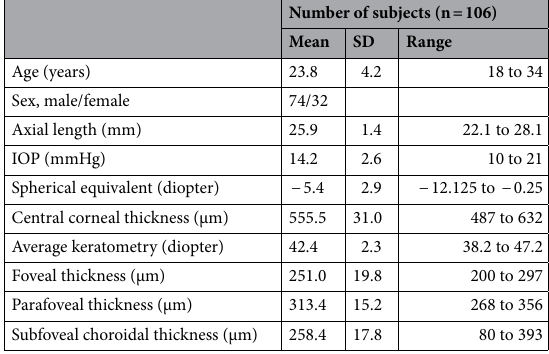
Table 1. Demographic and ocular factors of study subjects. IOP intraocular